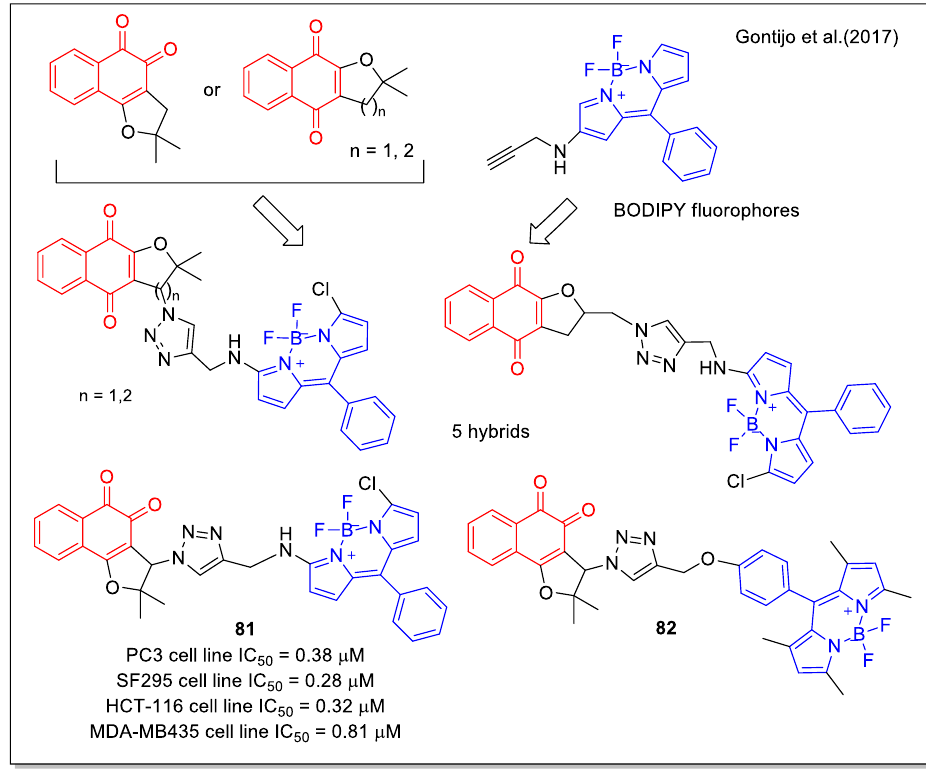
Figure 29. Nor-lapachone-BODYPY fluorophore hybrids as reported by Gontijo et al.